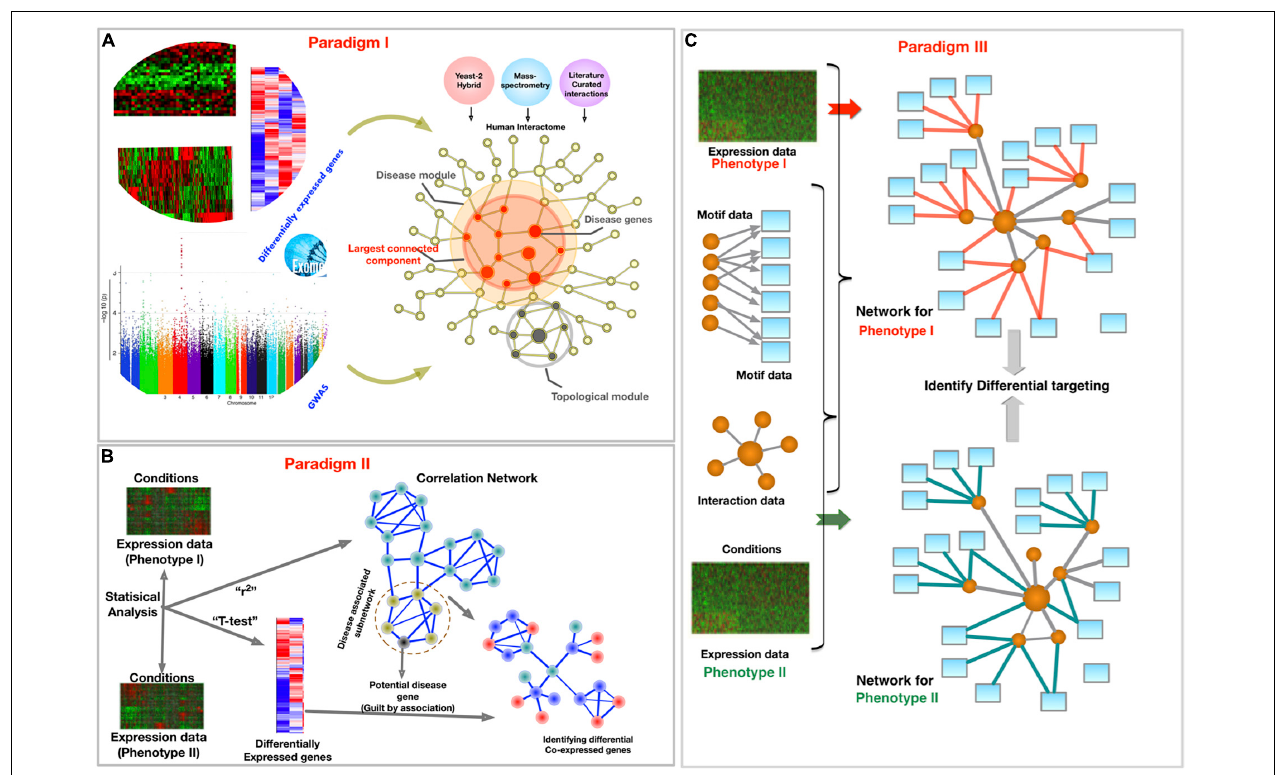
FIGURE 4 | Schematic of three paradigms for combining biological networks with phenotype-specific biomedical data, such as a set of disease genes and transcriptomic profiles for case and control groups. (A) Identification of disease-associated network components within the interactome. (B) Co-expression-based network modeling to identify disease biomarkers. (C) Constructing phenotype-specific GRNs to identify perturbations and condition-specific regulatory changes. Figure borrowed from Sonawane et al.